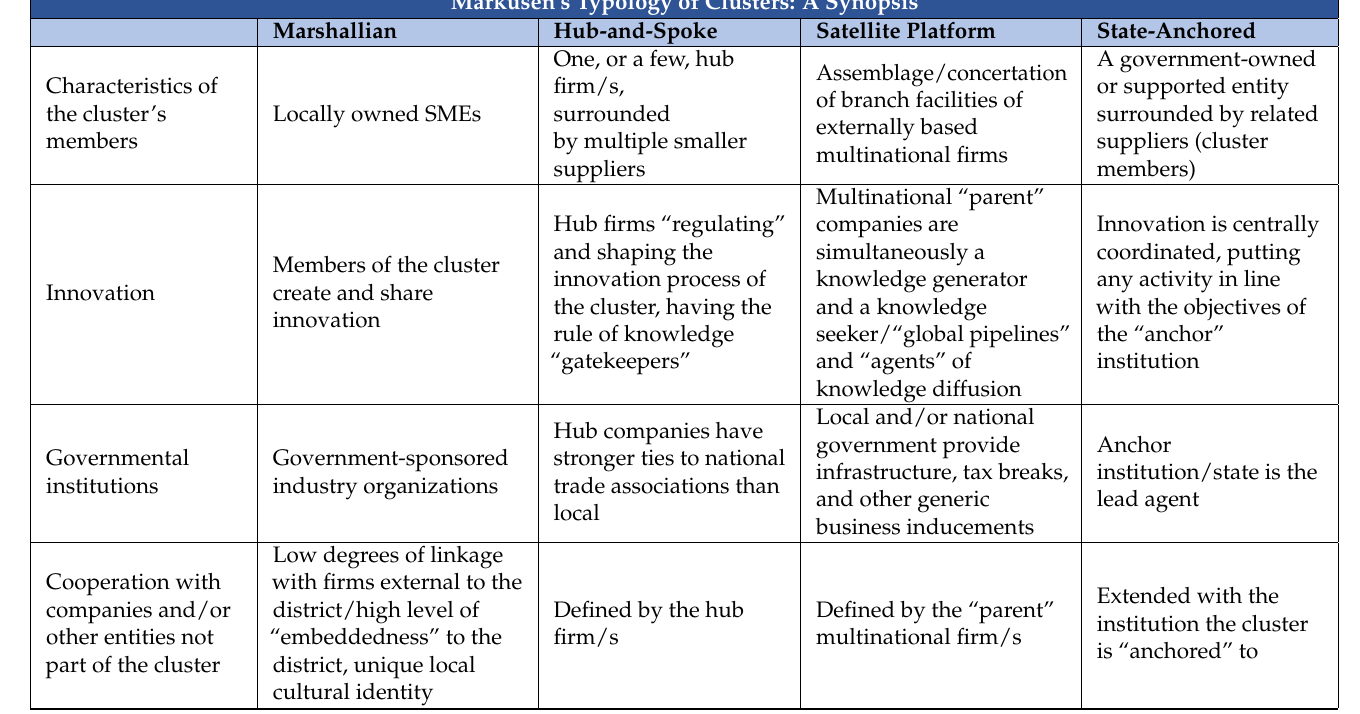
Table 1. Markusen’s typology of clusters: A